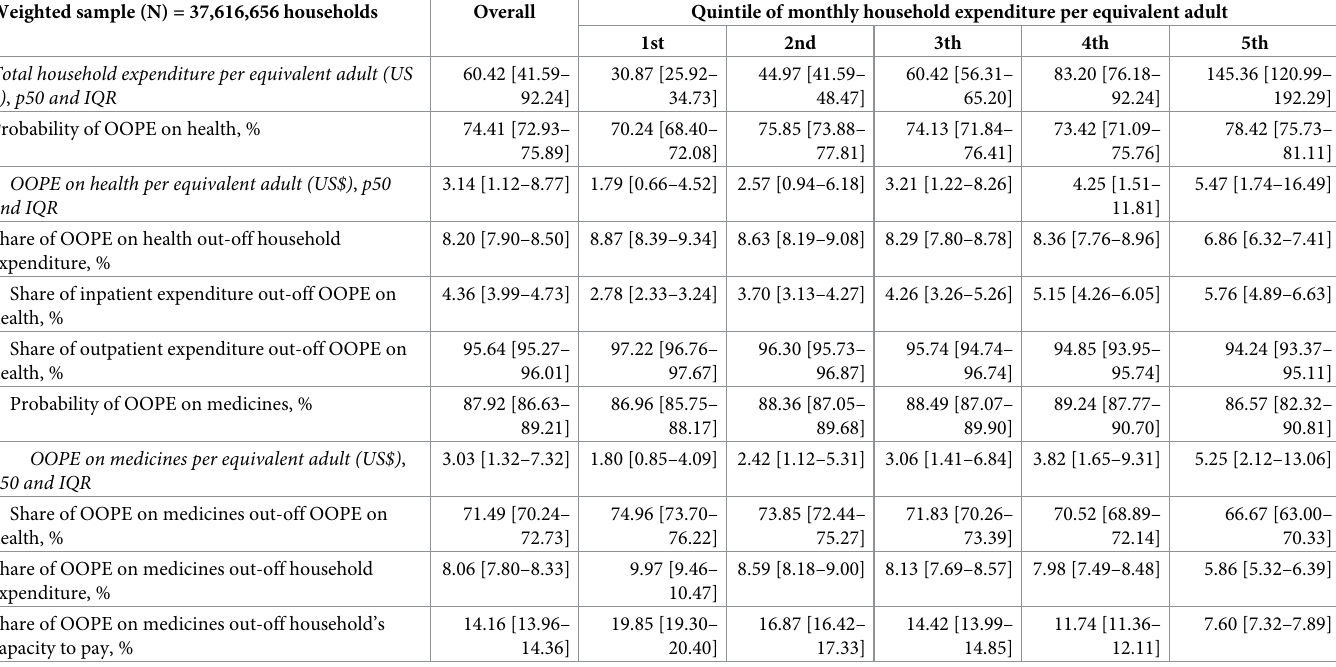
Table 2. OOPE on health and medicines according to quintile of household expenditure. HIES, Bangladesh, 2016. Weighted sample (N) = 37,616,656